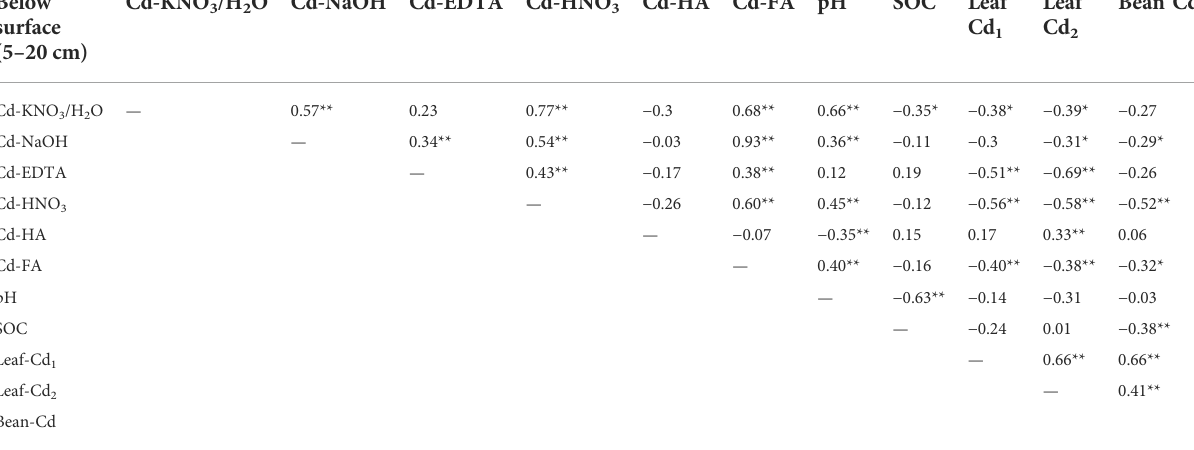
TABLE 5 Correlation matrix between the plant and soil parameters at the below surface (5 – 20 cm) soil depth. Below